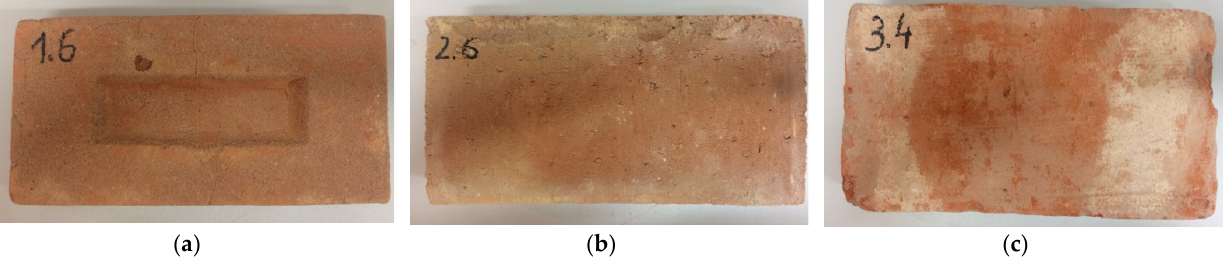
Figure 1. Samples of bricks: ( a ) hand-made, ( b ) factory-made, and ( c ) historic.